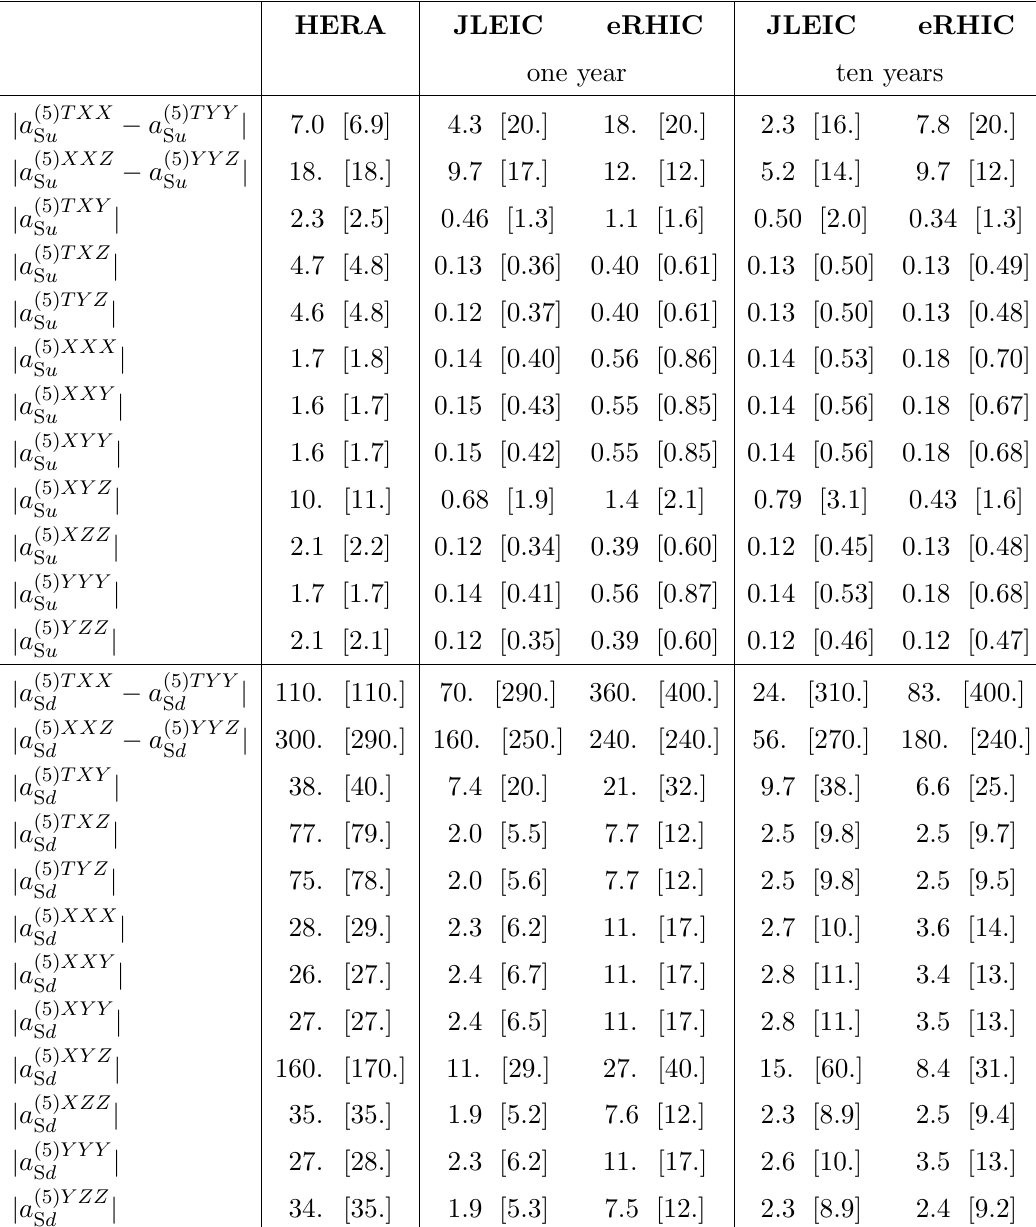
Table 2 . Best attainable sensitivities from DIS to individual coe(cid:14)cient components a (5) (cid:21)(cid:22)(cid:23) and a (5) (cid:21)(cid:22)(cid:23) estimated for HERA, JLEIC, and eRHIC. All values are in units of 10 (cid:0) 6 GeV (cid:0) 1 S d and re(cid:13)ect the orientation giving the greatest sensitivity. Results with brackets are associated with uncorrelated systematic uncertainties between binned data, while results without brackets correspond to the assumption of 100% correlation between systematic uncertainties. We provide estimated attainable sensitivities on coe(cid:14)cient magnitudes for both electron beam orientations, as detailed in ref. [31]. For JLEIC and eRHIC, sensitivities are listed for both one-year and ten-year data-taking con(cid:12)gurations.